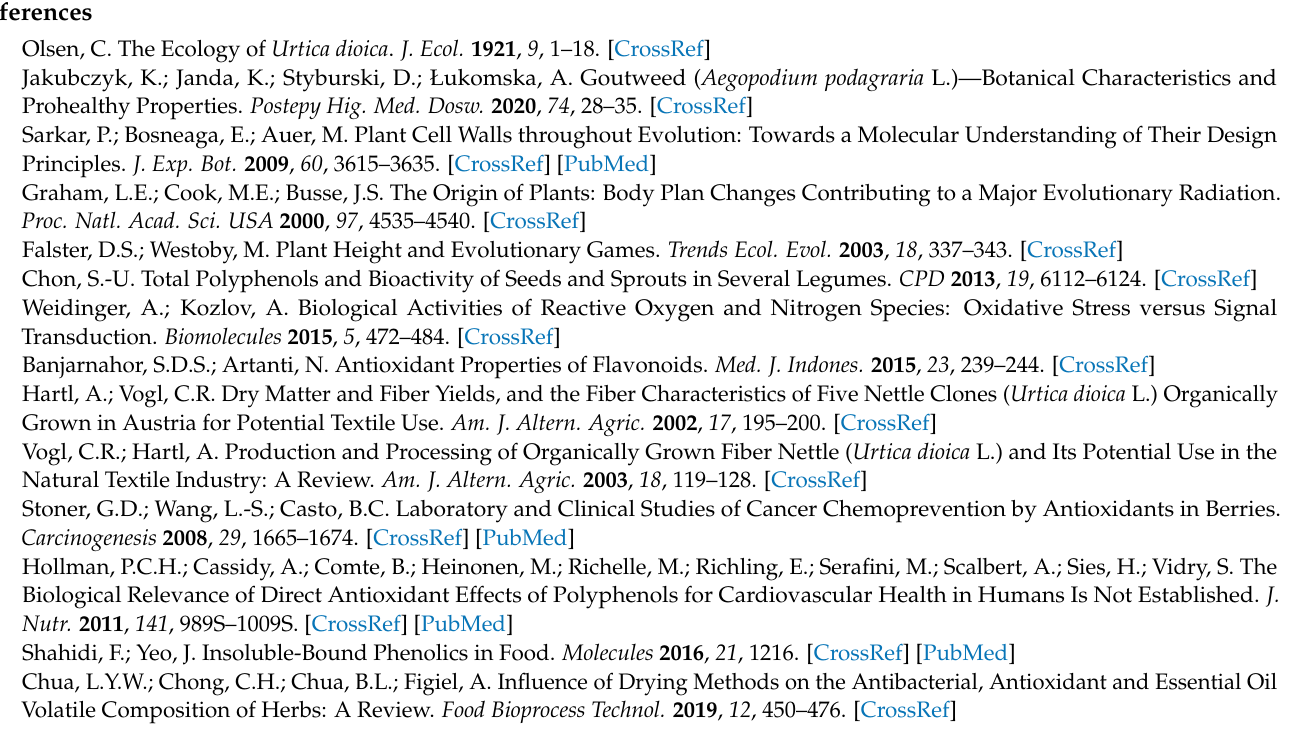
samples with added 5 caffeoylquinic acid (CQA) measured by (A) TEAC, (B) DPPH-, and (C) TPC assay. Figure S2. Antioxidant activity of (I) oven-dried and (II) freeze-dried uncooked (0 min) and cooked (5, 10, 15, and 20 min) from Aegopodium podagraria L. samples with added 5 caffeoylquinic acid (CQA) measured by (A) TEAC-, (B) DPPH-, and (C) TPC assay. Table S1. Mass spectra, retention times, and absorbance maxima of phenolic compounds and ascorbic acid derivatives tentatively identified in Urtica dioica L., by HPLC QQQ and HPLC DAD. Table S2. Concentrations of selected phenolic compounds and ascorbic acid derivatives [ µ g/mg sample] in Urtica dioica L. uncooked (0 min) and after 20 min of cooking. Table S3. Mass spectra, retention times, and absorbance maxima of phenolic compounds and ascorbic acid derivatives tentatively identified in Aegopodium podagraria L., by HPLC QQQ and HPLC DAD. Table S4. Concentrations of selected phenolic compounds and ascorbic acid derivatives [ µ g/mg sample] in Aegopodium podagraria L. uncooked (0 min) and after 20 min of cooking. Refs. [58–61] are cited in supplementary material